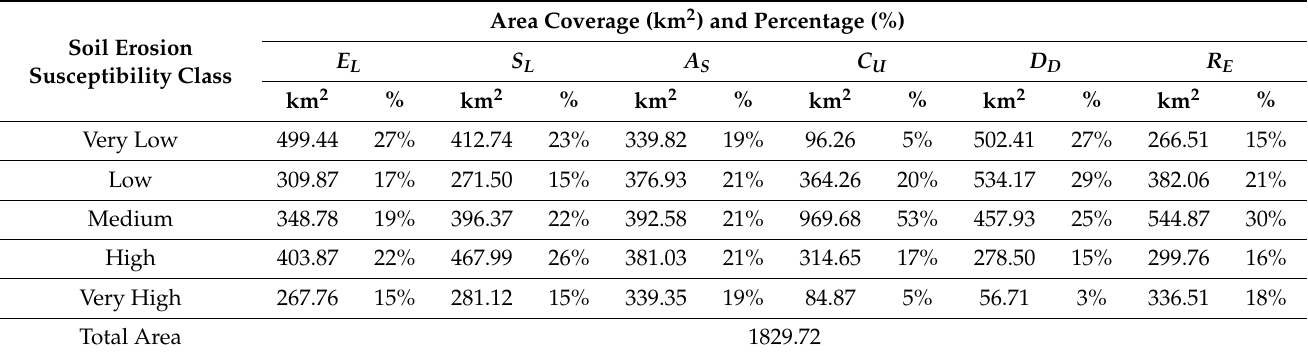
Figure 4. Soil erosion severity map of the Central Kashmir region. Table 6. Percentage distribution of elevation, slope, aspect, curvature, and rainfall. Table 5. Classes according to susceptibility to erosion.